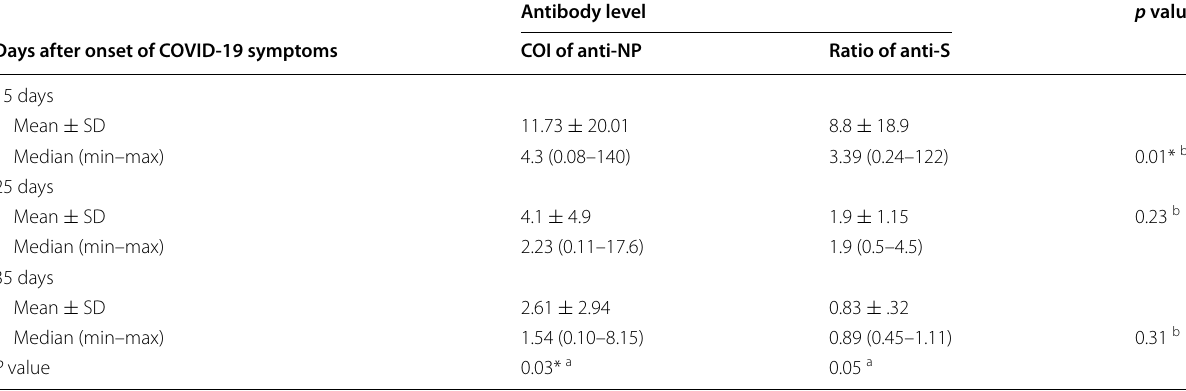
Table 1 Mean and median of SARS-CoV-2 anti-NP (COI) and anti-S (ratio) after 15, 25, and 35 days after onset of symptoms of COVID-